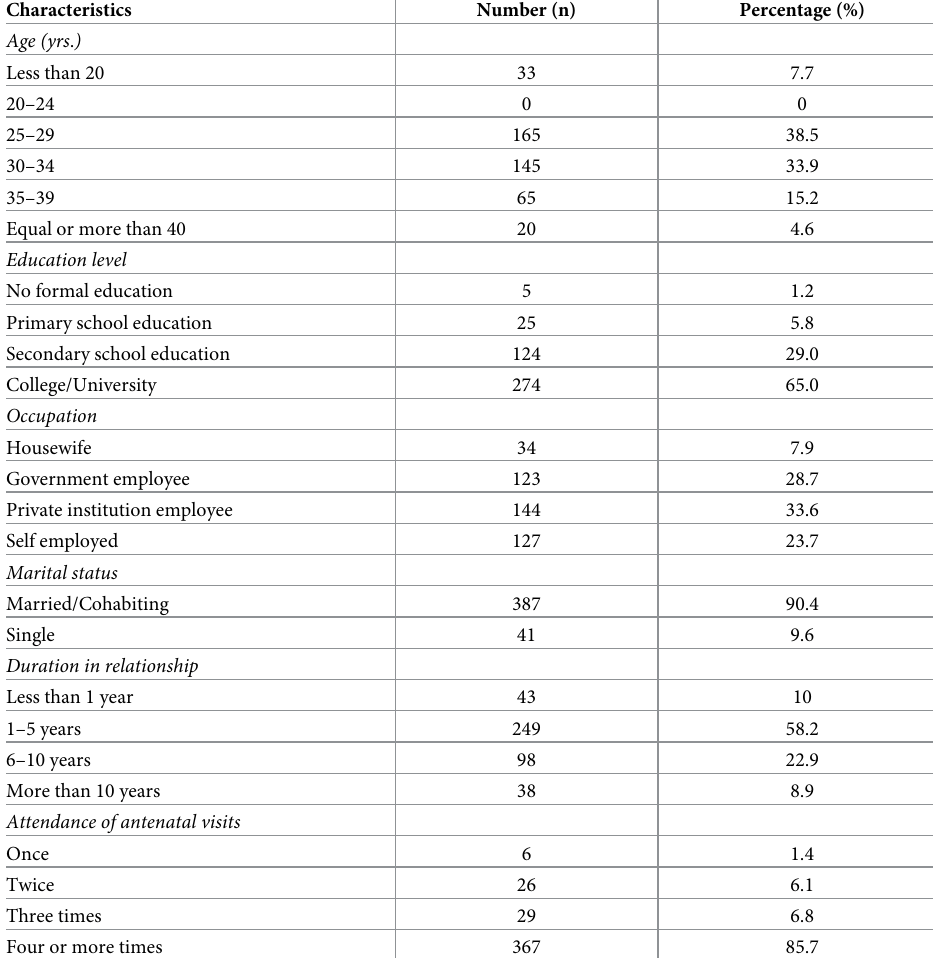
Table 1. Percentage distribution of background characteristics of studied group (N =